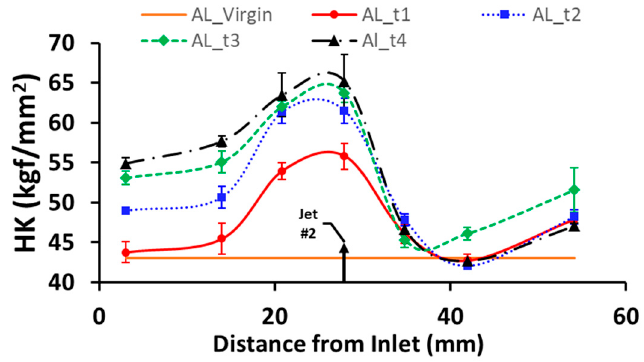
Figure 15. Hardness distribution under various process times.